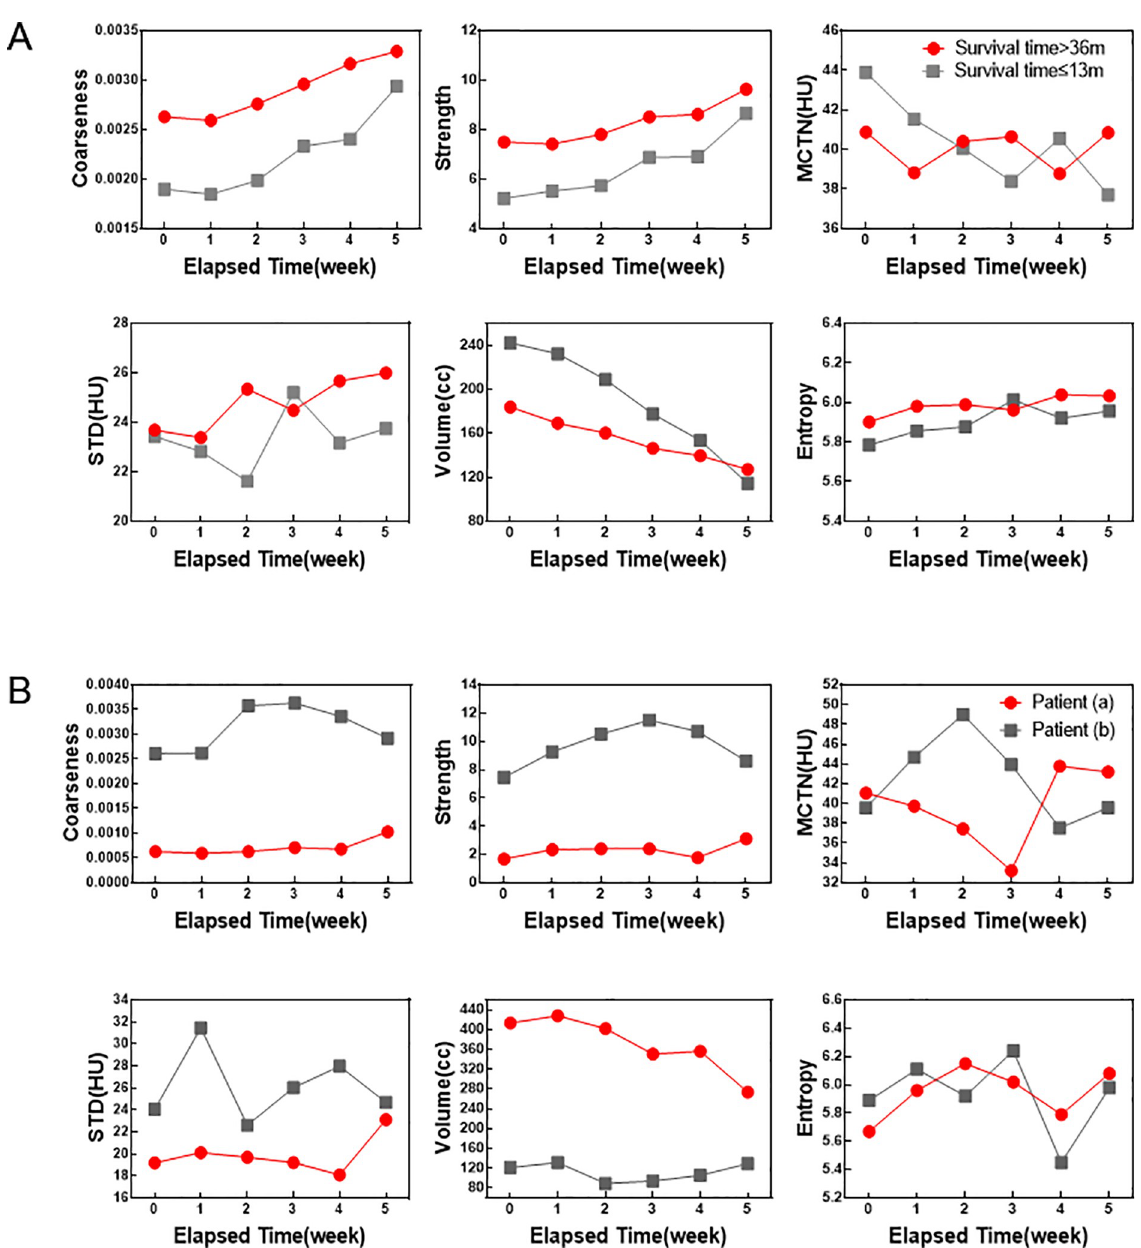
Fig 3. Correlation between texture features and survival. (A)Comparisons for texture features between the two groups with one had a survival greater than 36 months and one less than 13 months along the increase of elapsed time. (B) Analysis of two typical cases, (a) Patient 10 and (b) Patient